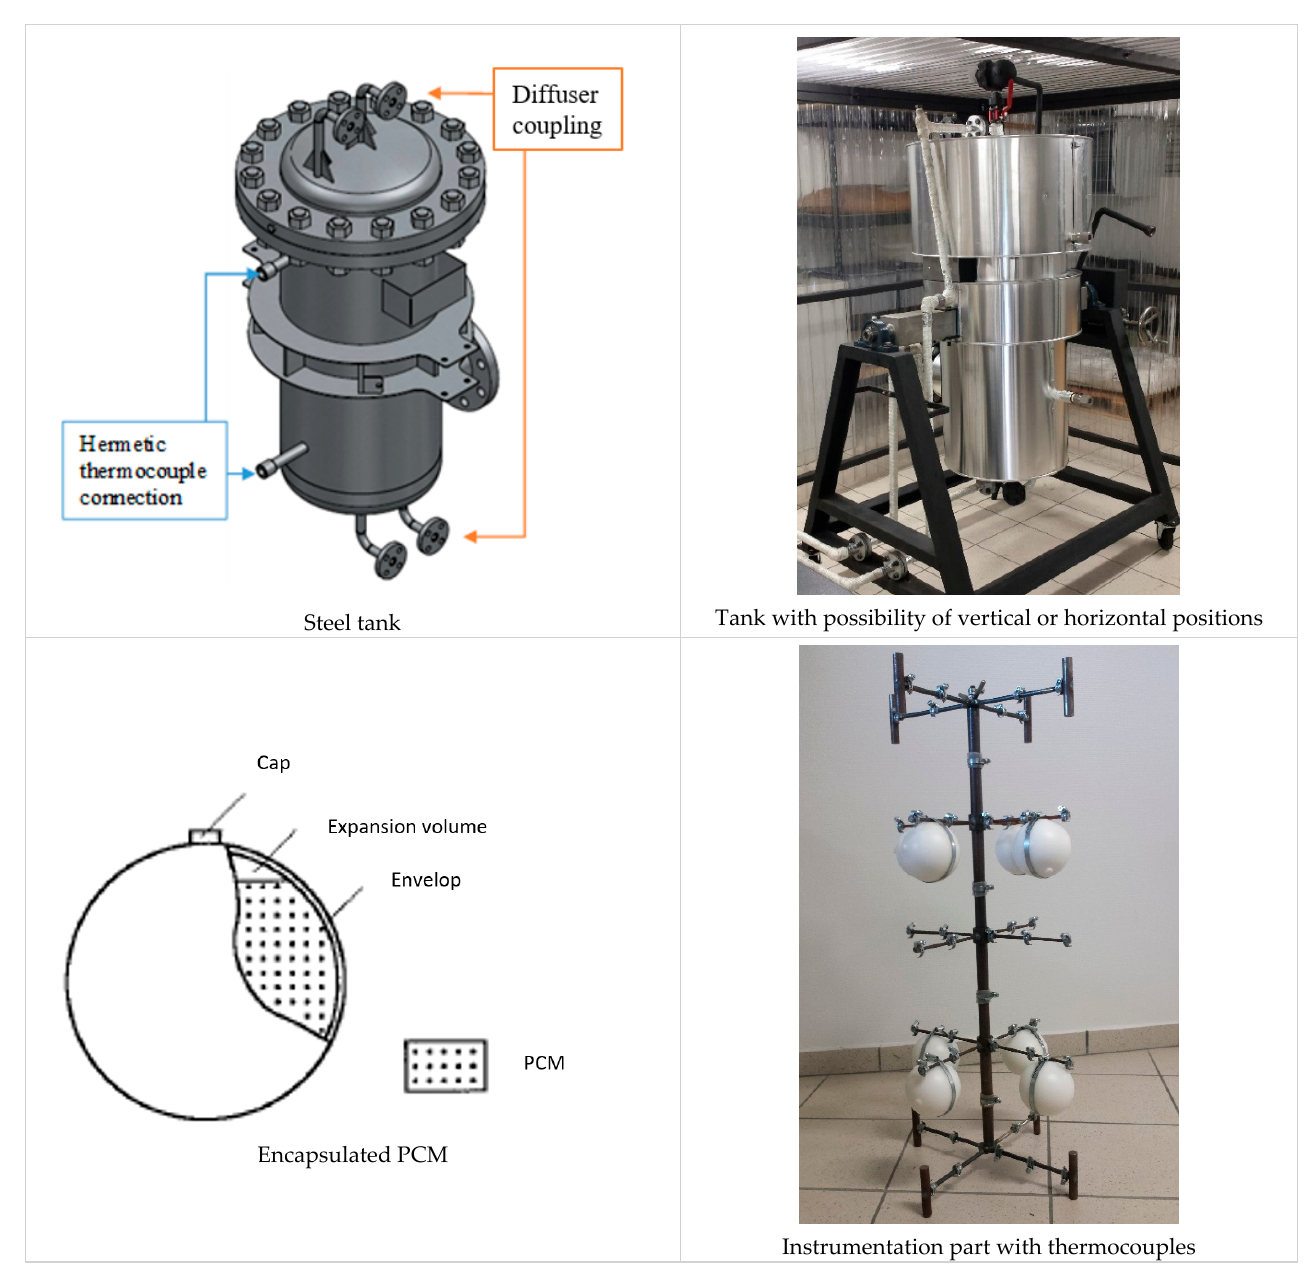
Figure 5. Laboratory-scale latent TES prototype.